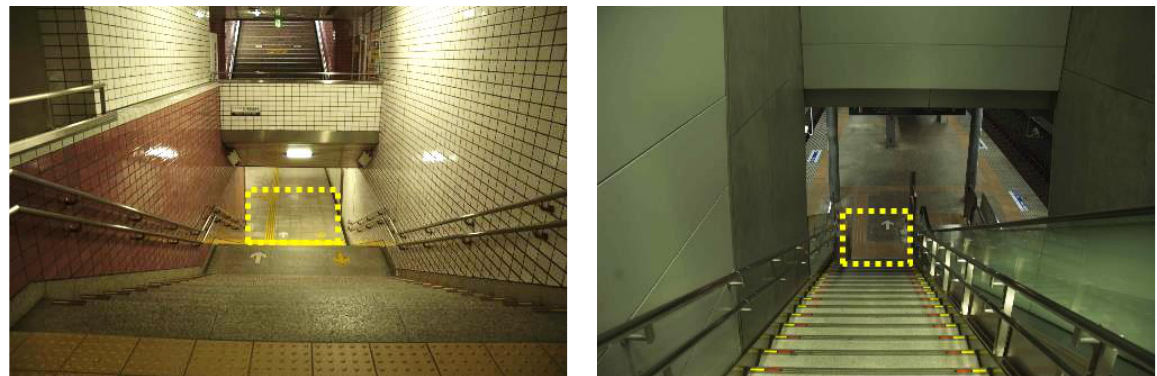
Figure 3. Entrance of No. 12 and 19 (( left ): No. 12, ( right ): No. 19).